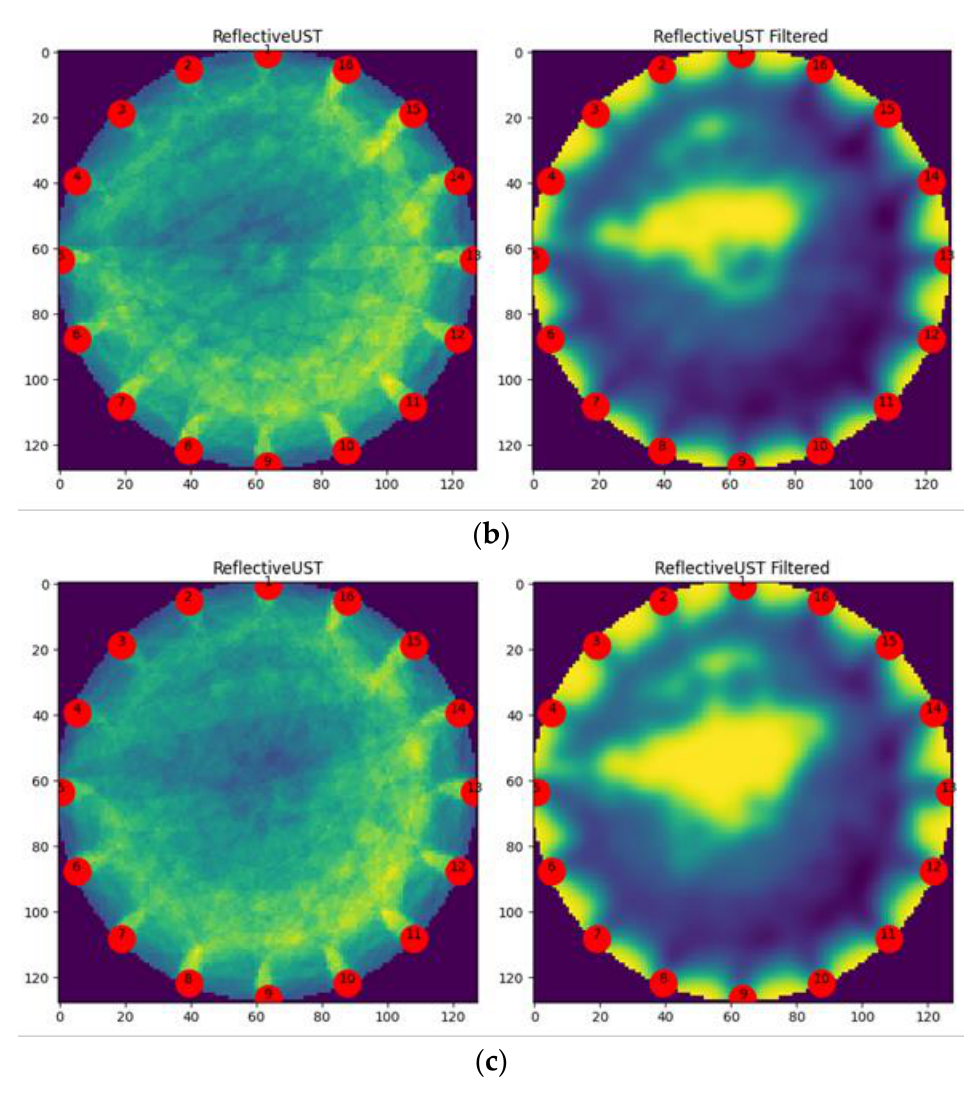
Figure 14. Evolution of the crystallisation process over time: ( a ) at the beginning of crystallisation, ( b ) after 2 min, ( c ) after 5 min. Each subfigure shows two reconstructions without and with filter.